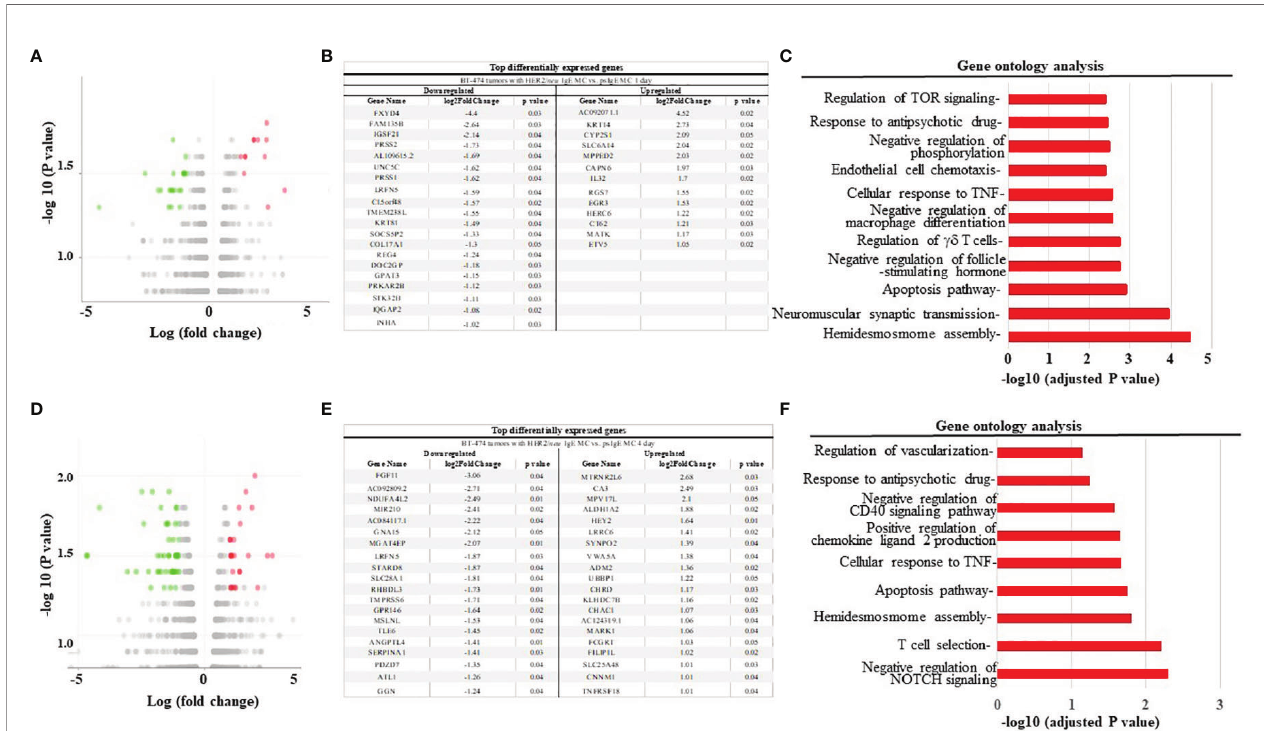
FIGURE 6 | HER2/ neu -sensitized ADMC induce apoptosis of HER2/ neu -positive BT474-1261 tumors through a unique set of gene pathways. (A, D) Volcano plot of differentially expressed genes in tumors from mice engrafted with human female BT474-1261 cells. When tumors reached 200 mm 3 , 1 x 10 6 HER2/ neu or psIgE sensitized ADMC from a male human donor were injected intratumorally. Tumors were harvested after 1 (A) or 4 day (D) and scRNAseq was performed on the tumor samples. Adoptively transferred ADMC were distinguished from BT474-1261 tumors by Y-chromosome gene mapping. Red and green indicate signi fi cant (P < 0.05) differences in psIgE vs HER2/ neu treated animals. Each data point in the scatter plot represents a gene. The log2 fold change of each gene is represented on the x-axis and the log10 of its p-value is on the y-axis. Genes with a p-value less than 0.05 and a log2 fold change greater than 1 are indicated by red dots (upregulated) and those with less than -1 are indicated by green dots (downregulated). The top genes signi fi cantly up or down regulated are shown at days 1 (B) and 4 (E) . Gene ontology analysis was performed on the statistically signi fi cant set of genes by implementing the software GeneSCF v.1.1-p2. The mgi GO list was used to cluster the set of genes based on their biological processes and determine their statistical signi fi cance. A list of genes clustered based on their gene ontologies was generated for tumors treated with HER2/ neu IgE-sensitized vs. psIgE sensitized ADMC at day 1 (C) and 4 (F)